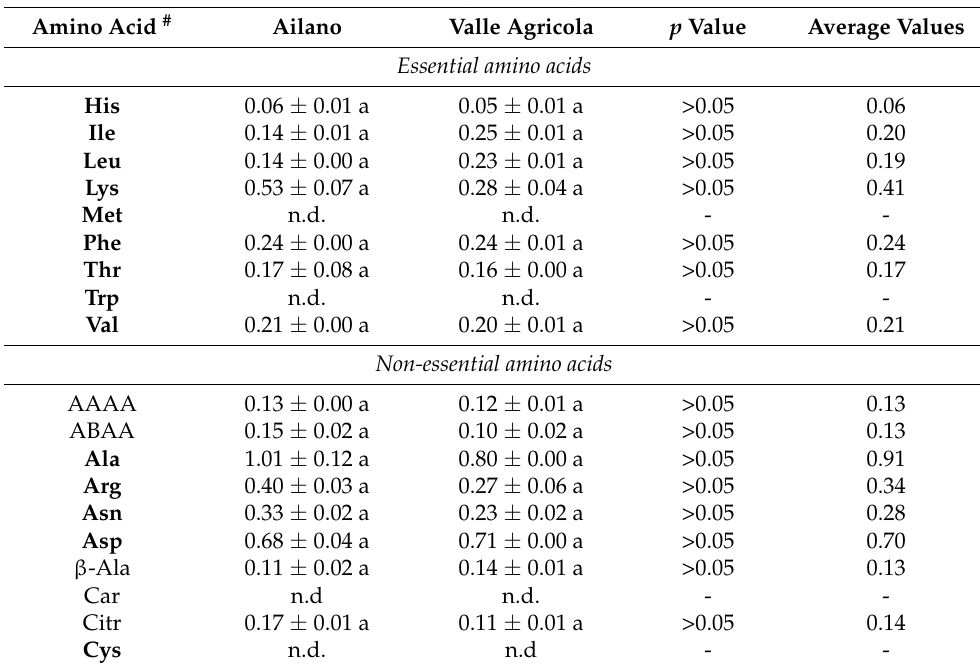
Table 2. Free amino acid composition of cow raw milk from ‘Ailano’ and ‘Valle Agricola’. Values are means ( ± SD) and are expressed as mg per 100 g of milk. See Section 2.2 of Materials and Methods section for more